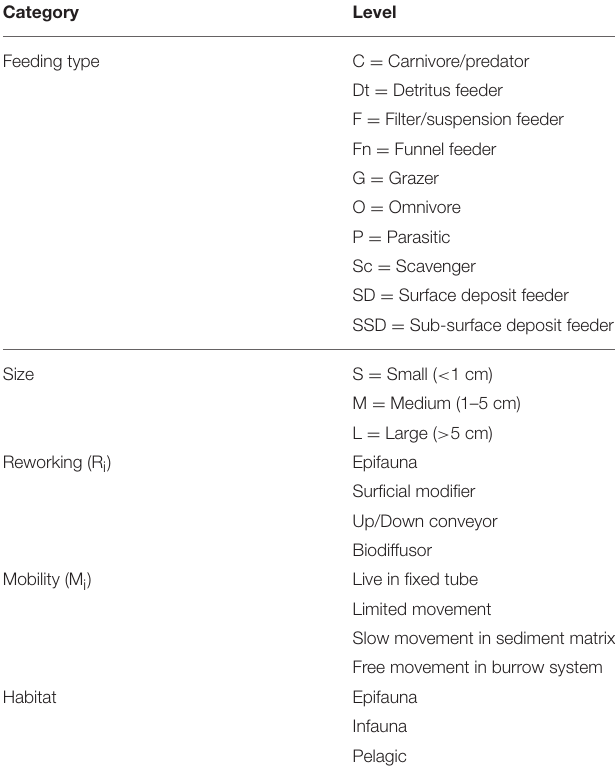
TABLE 2 | Biological traits used in the functional diversity